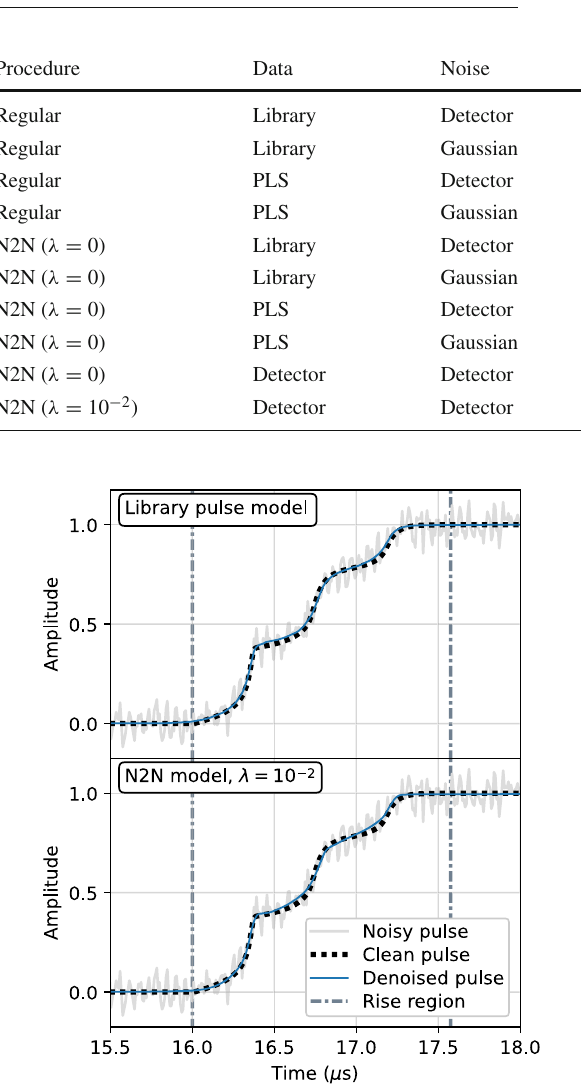
Table 3 Summary of the mean squared error on the test sets for different models. The procedure, dataset, and noise type used in the training are given Training procedure and data